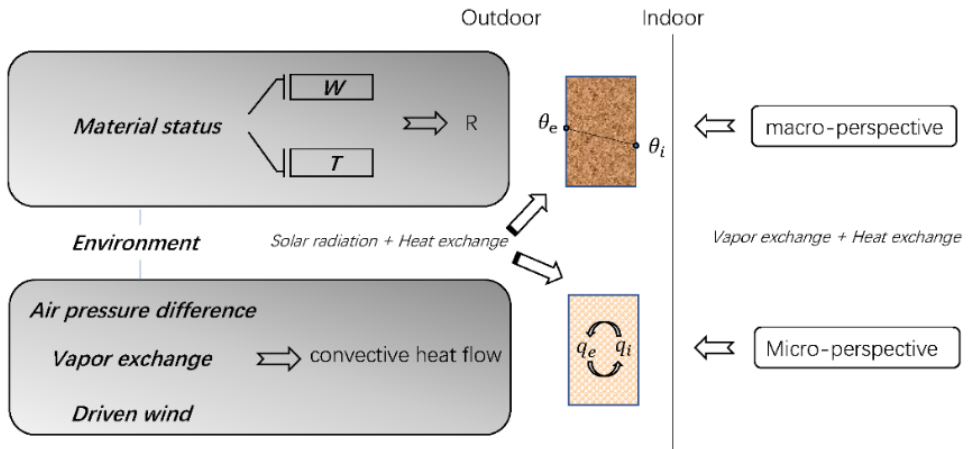
Figure 5. Analysis of heat transfer forms. Table 4. Relationship between Thickness and the Heat Transfer